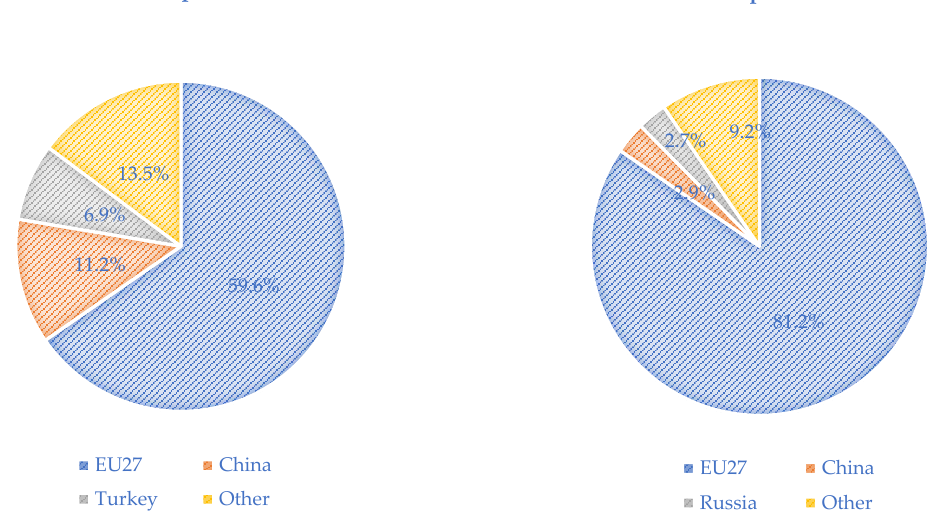
Figure 5. Share of goods, imports to the WB, and exports from the WB (excluding inter-regional trade) by trading partner in 2021 [92].